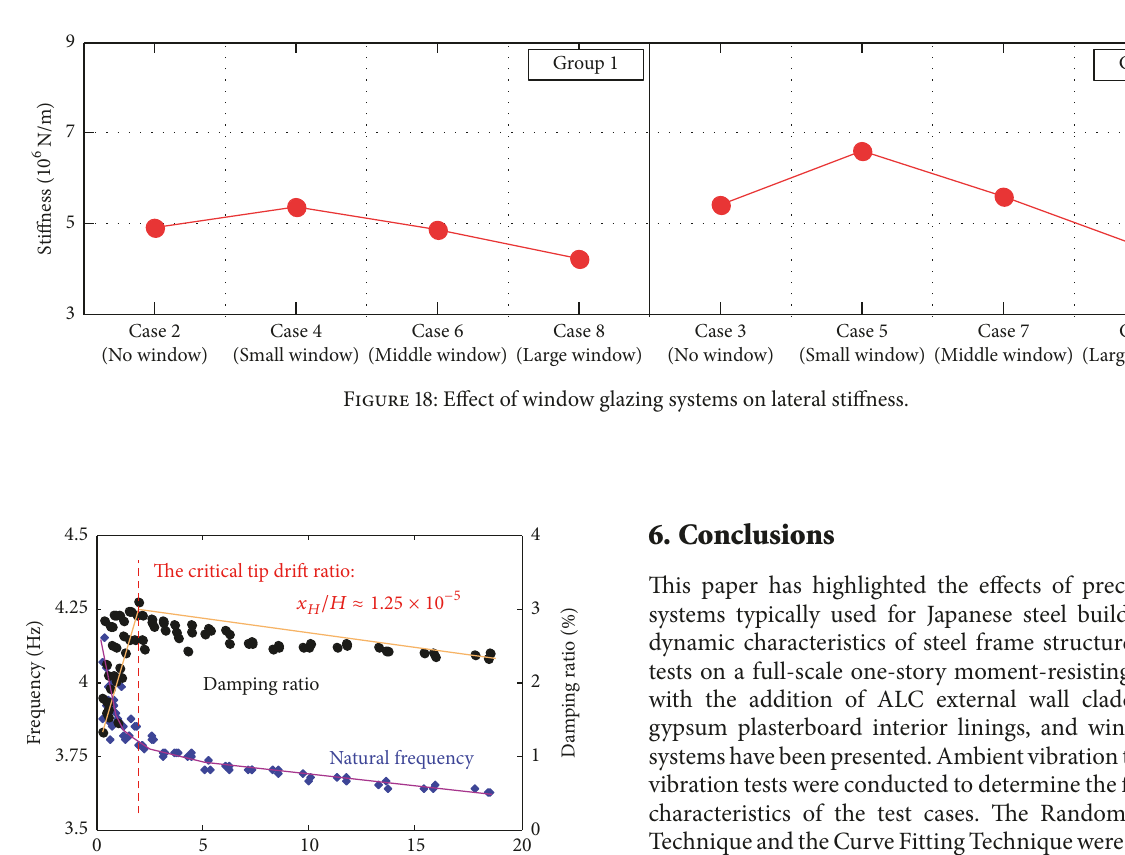
Figure 17: Effect of plasterboard on lateral stiffness.